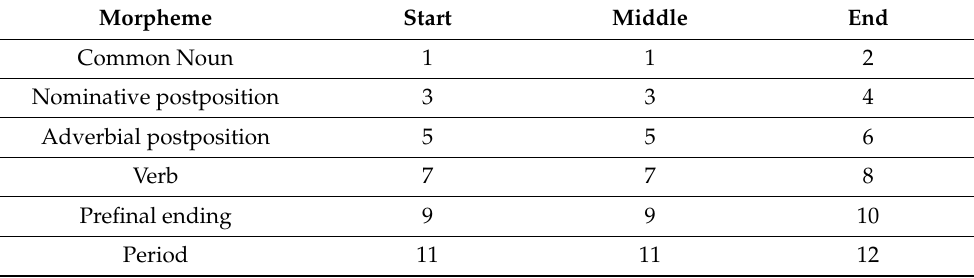
Table 3. Morpheme level encoding example.